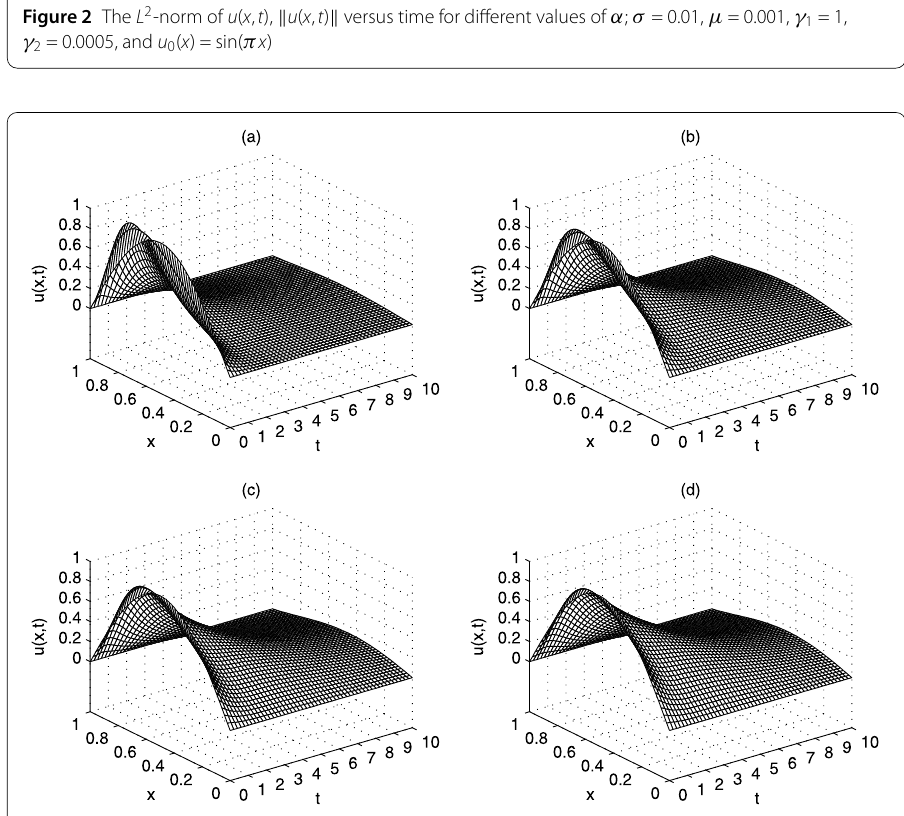
Figure 3 A 3-d landscape of the dynamics of the MGKdVB equation using the linear adaptive control law; σ = 0.01, γ 1 = 1, r 1 = 0.2, and u 0 ( x ) = sin( π x ); ( a ) α = 1; ( b ) α = 2; ( c ) α = 3; ( d ) α = 4